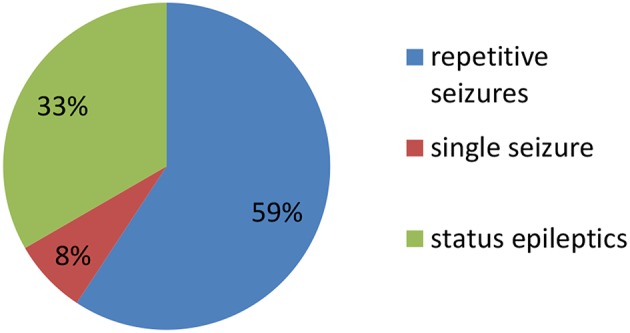
Percentage of patients with repetitive seizures, single seizure, and status epilepticus (SE).